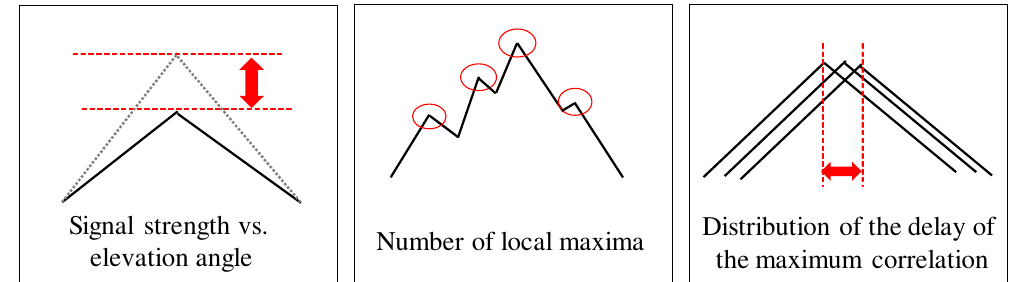
Figure 5. Three types of NLOS features are extracted from GNSS signal correlation outputs and are used for NLOS classification applying a support vector machine